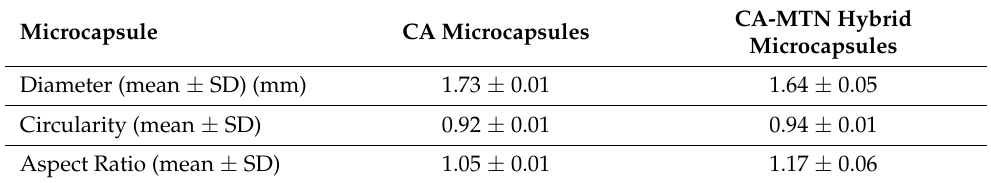
Table 3. Size and morphology parameters of CA and hybrid CA-MTN microcapsules.